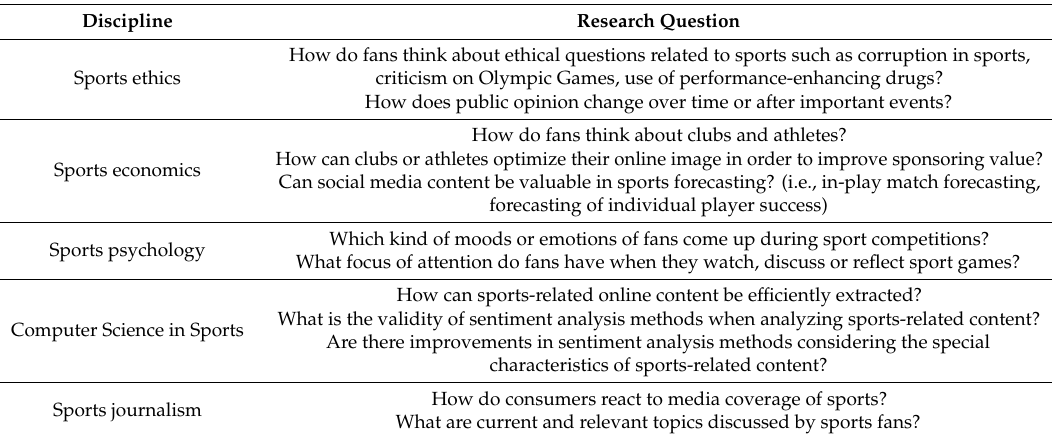
Table 1. Research questions related to social media analysis that could profit from algorithmic solutions of sentiment